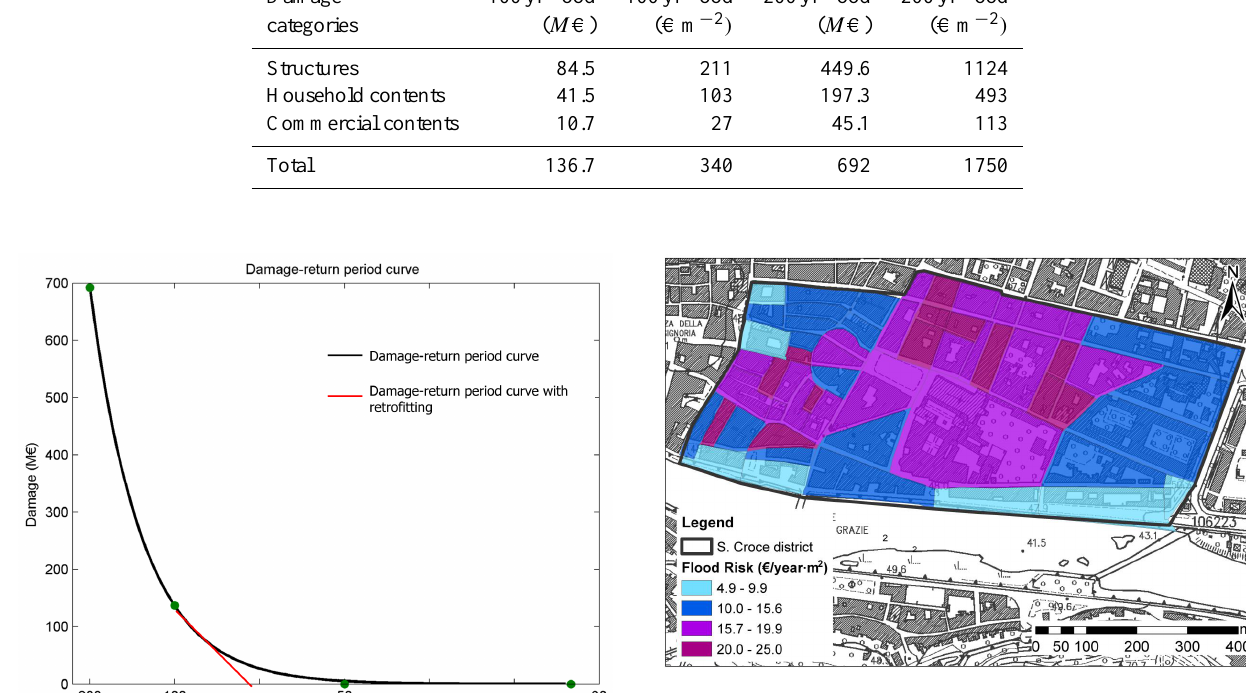
Figure 14. Flood risk map for the S. Croce district (€/m 2 .year). Values are for unit surface 2 Fig. 14. Flood risk map for the St. Croce district (Cm − 2 yr − 1 ). area of census sections. 3 Values are for unit surface area of census